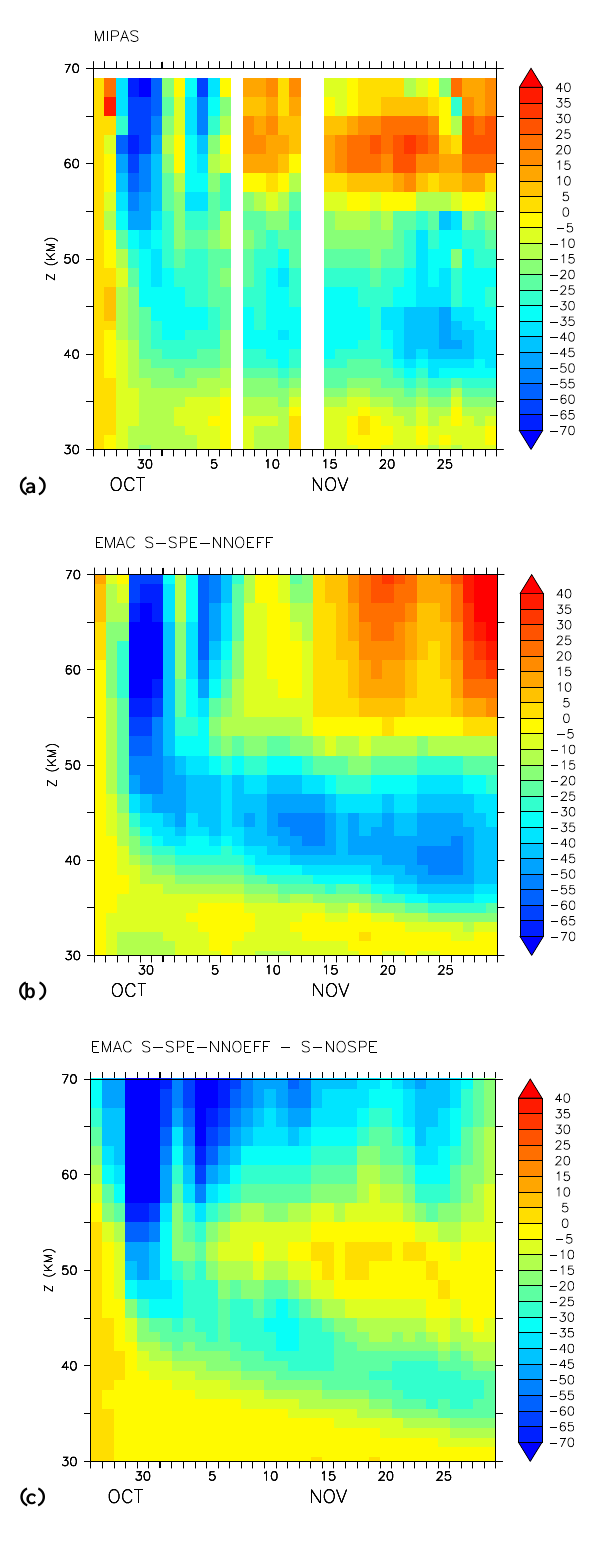
Fig. 12. Ozone mixing ratio percentage change; (a) MIPAS, relative to 26 October, (b) EMAC S-SPE-NNOEFF, relative to 26 October, (c) difference between EMAC S-SPE-NNOEFF and S-NOSPE.